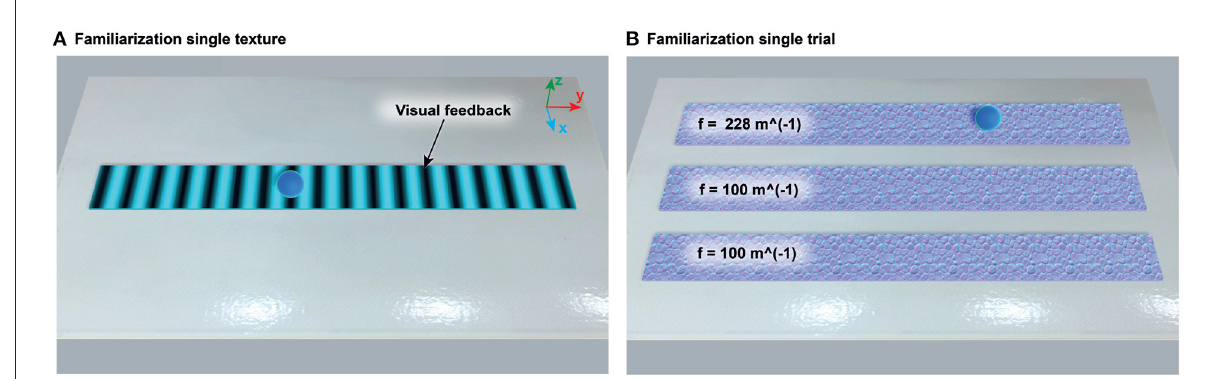
FIGURE5 Virtual environments during familiarization. (A) The visual feedback that mapped the grating rendering was shown to help participants understand the haptic stimuli provided during the experiment. The dark color represented grooves, while the light blue color represented texture crests. Participants were encouraged to actively explore the texture as much as desired. (B) After the single texture familiarization, participants were asked to discriminate the odd texture among three virtual textures with identical visualization. The texture combination used for all participants was 228, 100, and 100 m − 1 ,